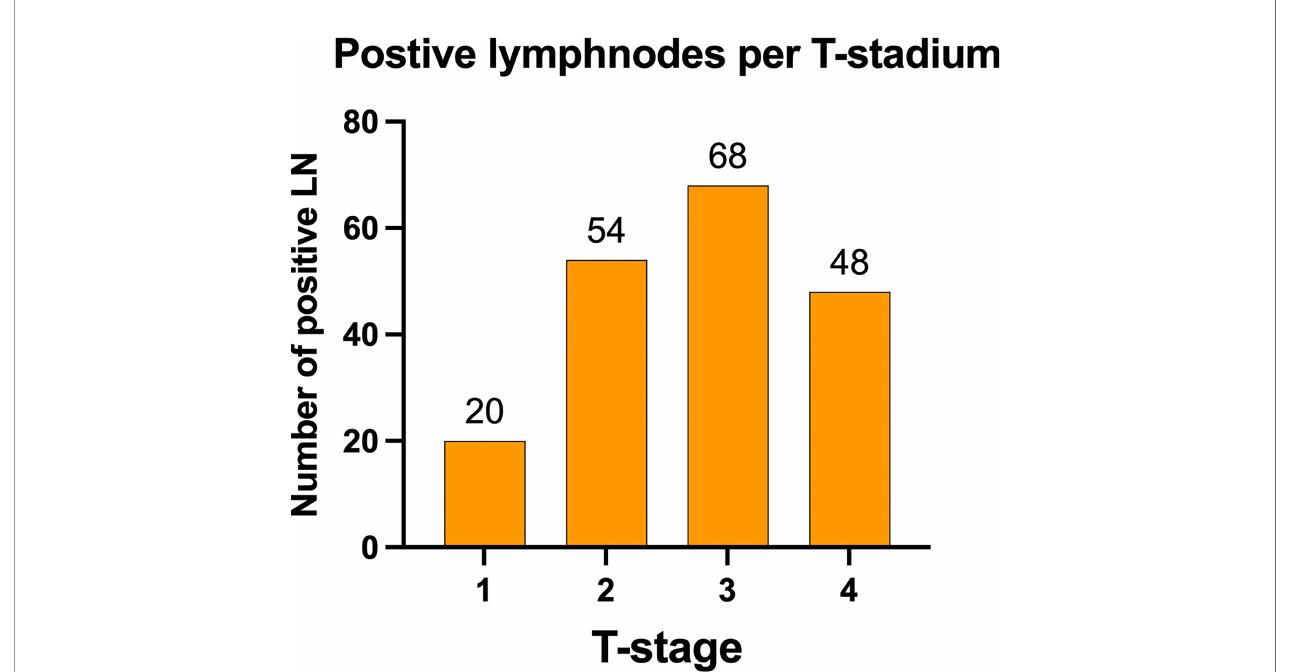
FIGURE 4 | Distribution of positive lymph nodes according to tumor stage. Lymph node metastasis was predominately found in patients with primary tumors staged T2 and higher, with an almost equal distribution between T2 (28.42%), T3 (35.79%), and T4 (25.26%). Only 10.53% lymph node metastasis were found in T1 primary tumors. Data are presented as total values based on n=190 LN metastases in n=177